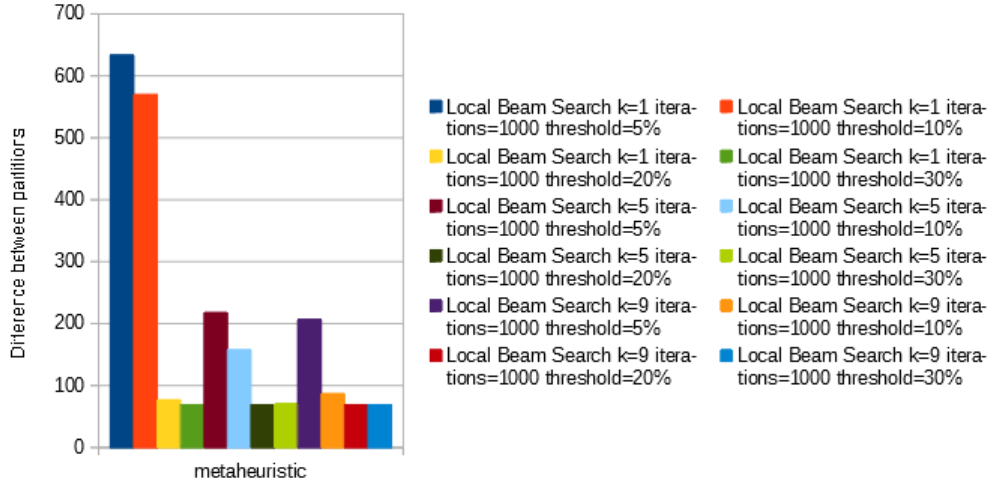
Figure 7. Comparison of local beam search between threshold and number of candidates per iteration fixing the number of iterations in 1000.